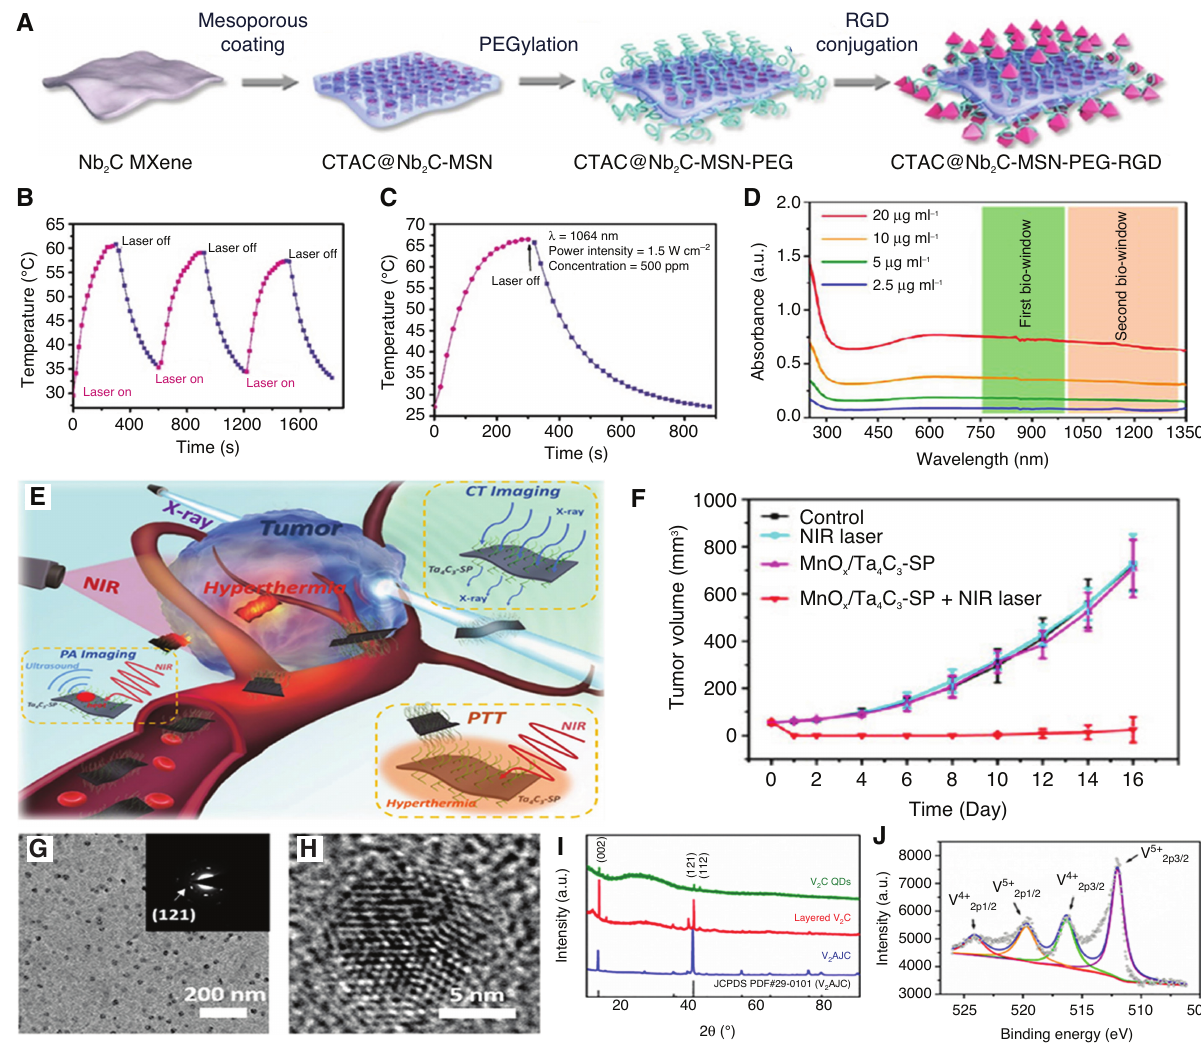
C -based PTT of cancer. Figure 5: Non Ti 3 2 (A) Synthesis steps and surface PEGylation/targeting modification scheme of CTAC@Nb dispersed in water during three laser on/off cycles under 1064 nm laser irradiation (1.5 W cm −2 ) [86]. (C) Photothermal properties of CTAC@ Nb C-MSN dispersed in aqueous solution under NIR radiation [86]. (D) Visible-NIR absorbance spectra of aqueous suspensions of dispersed 2 Nb C NSs at various concentrations (2.5, 5, 10, and 20 μ g ml −1 ). Inset: First NIR biowindow (NIR-I; 750–1000 nm) and second NIR biowindow 2 (NIR-II, 1000–1350 nm) [24]. (E) Schematic diagram of Ta PTT [78]. (F) Tumor growth curve over time in four groups (control group, NIR laser group, MnO laser group) after receiving different disposes [87]. (G) Transmission electron microscopy (TEM) images of V transform pattern of V C-QDs [88]. (H) High-resolution TEM images of V 2 spectroscopy of V C-QDs 2